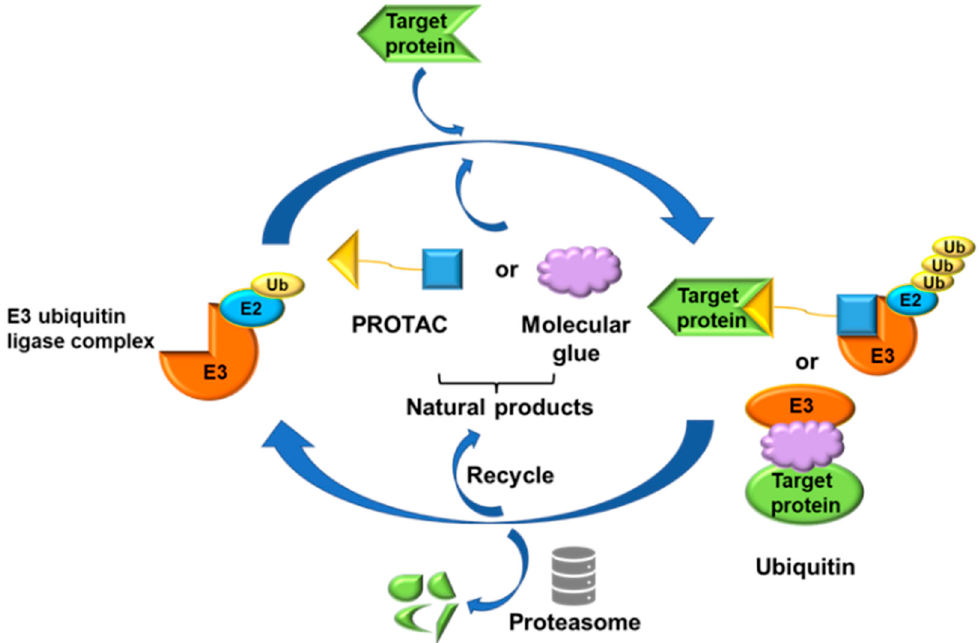
Figure 1. Mechanism of action of PROTAC and molecular glue technology.